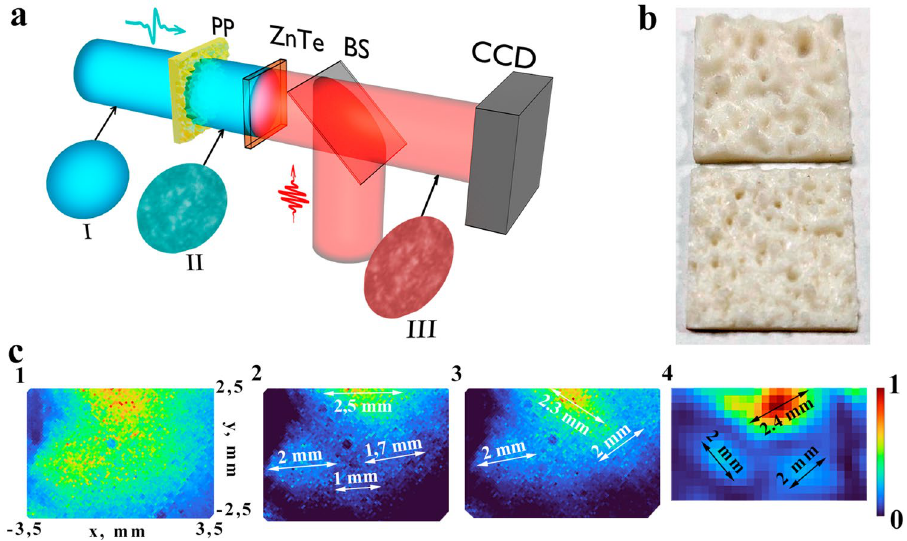
Figure 3. ( a ) Schematic diagram of detection system in THz imaging setup. The Gaussian THz field (I) passes through the transparent phase plate with a random distribution, where it changes its spatial distribution (II). After that, the THz field is detected by the EOS in each pixel of the camera using probe beam (III). In this experiment, the probe beam changes its time delay relative to the THz field and makes it possible to detect the time profile of the THz pulse. ( b ) Photo of the phase plates made from ABS plastic (n(THz) = 1.55) [parameters: h RMS = 0.8 mm and Cl = 1.5 mm (top), h RMS = 0.6 mm and Cl = 0.9 mm (bottom)]. ( c ) Initial THz profile ( 1 ) and resulting THz speckle patterns obtained from the radiation intensity recorded on an imaging setup for the case in which THz radiation propagates through the phase plates ( 2 is b (top) and 3 is b (bottom)) located at a distance of 5 cm from the ZnTe crystal, 4 —typical result of numerical calculation of speckle pattern formation for the same conditions as in